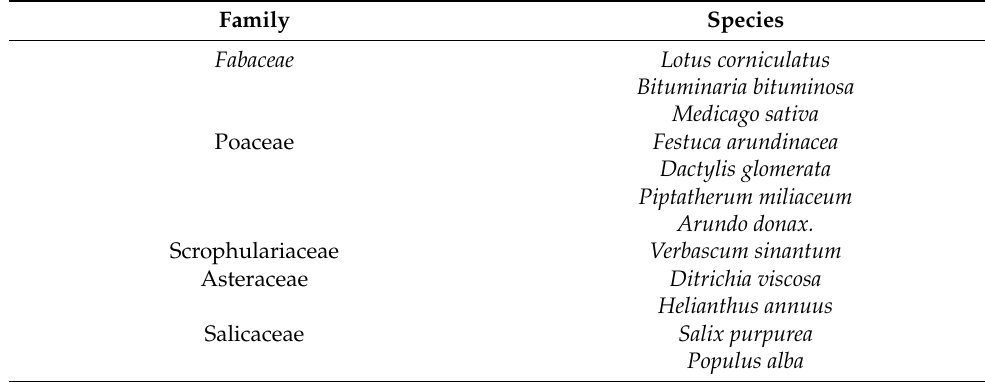
Table 2. Plants used in mesocosms experiment (Adapted from